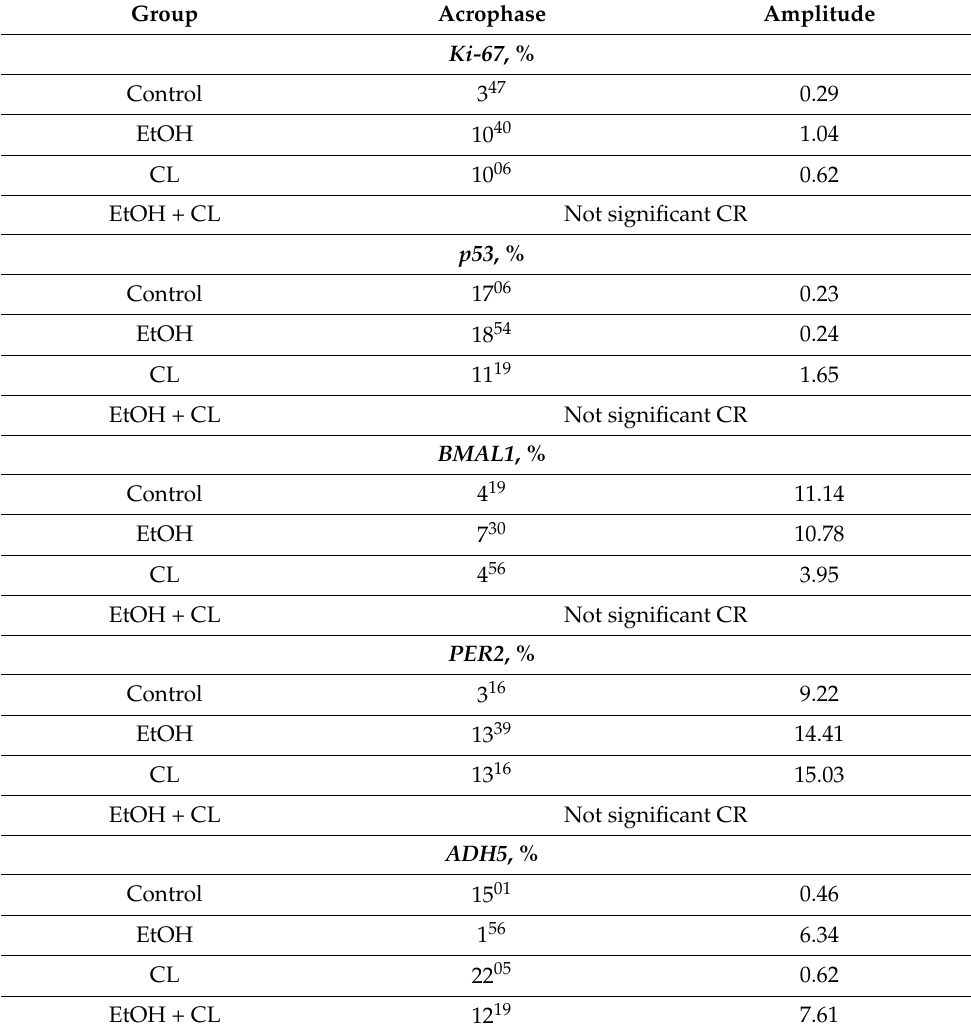
Figure 17. Daily dynamics of p53 expression in hepatocytes of rats.